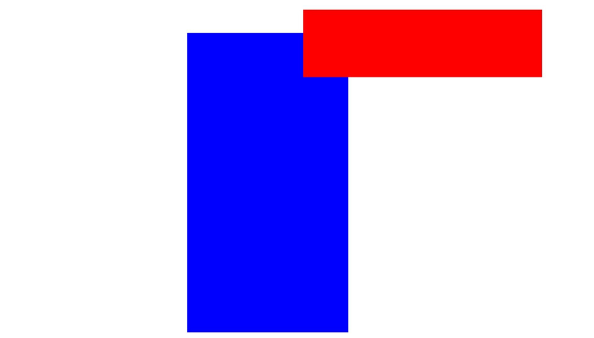
Figure 2 | A still from the Webdriver Torso Youtube Channel. Accessed